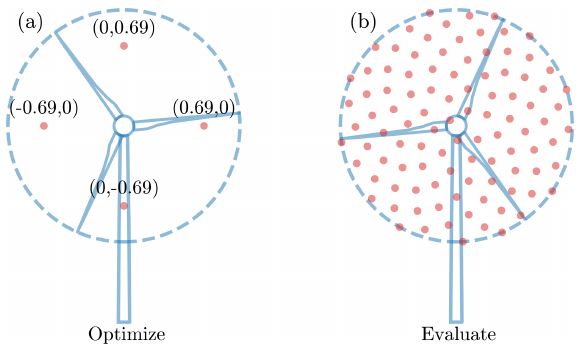
Figure 5. The sampling points across the swept rotor area to calcu- late the effective wind speed at the turbine. Wind speeds are sam- pled at each point and then averaged. (a) The sparse sampling loca- tions used during optimization. The coordinates shown are normal- ized by the rotor radius. (b) The 100 sample points used for final